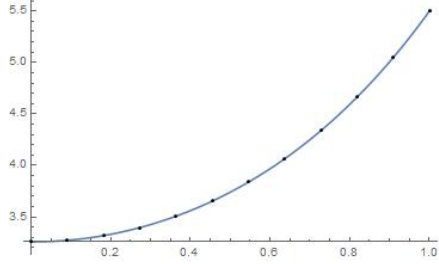
Figure 1. Exact solution of Example 1 and a discrete one for M = 11.